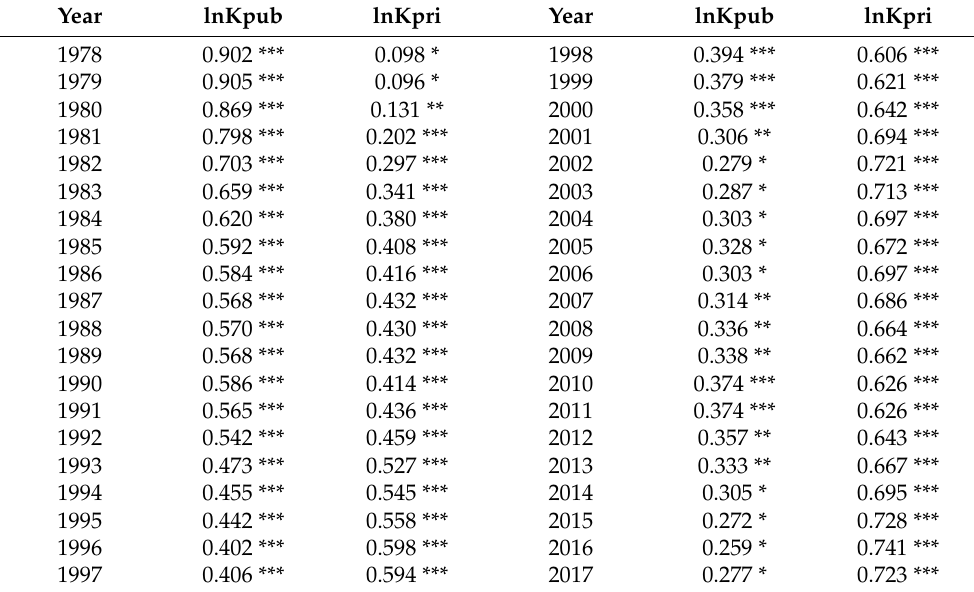
Table 2. Capital regression coefficients of the production